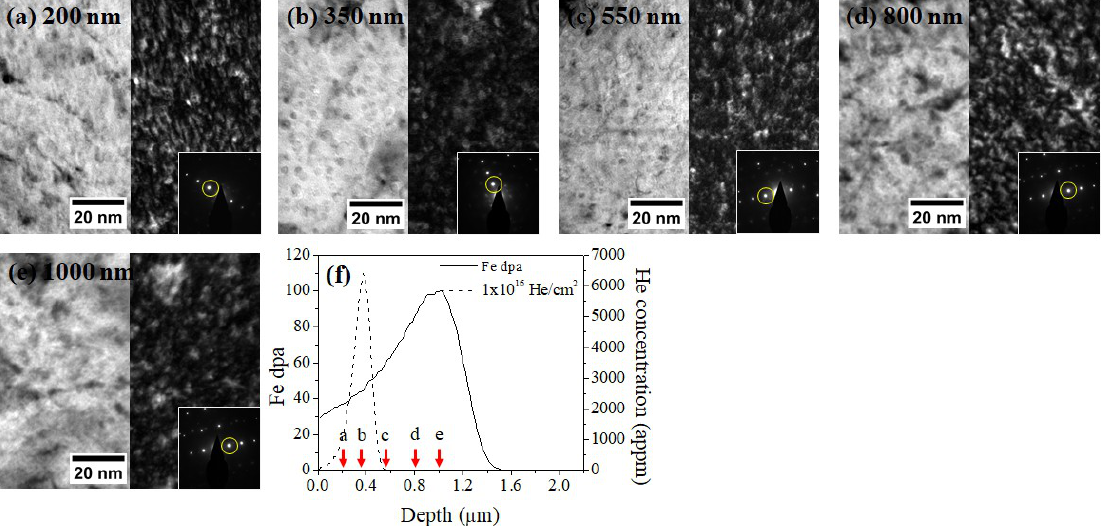
Figure 8. TEM bright-field and dark-field micrographs of the 1 × 10 16 He preimplanted and Fe irradiated specimen taken from depths of ( a ) 200, ( b ) 350, ( c ) 550, ( d ) 800, and ( e ) 1000 nm. Diffraction patterns obtained from the same grain are superimposed on each DF image with g110 marked by a yellow circle. ( f ) SRIM calculations are provided to show the depths of TEM characterization. A dispersoid density increase was not observed in ( b ).